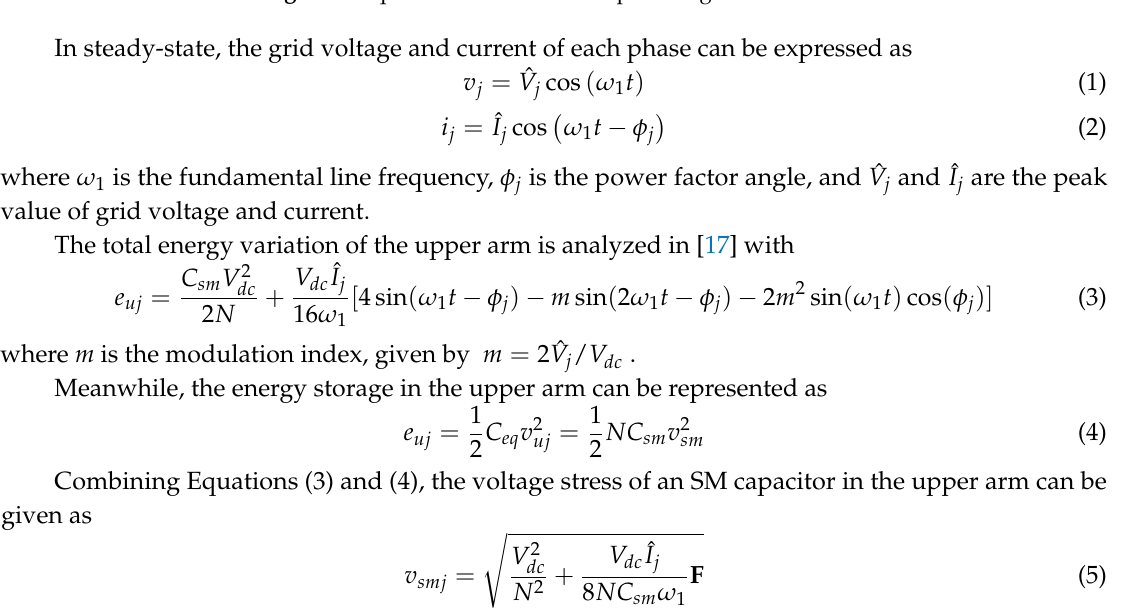
Figure 2. Equivalent circuit of each phase-leg of the